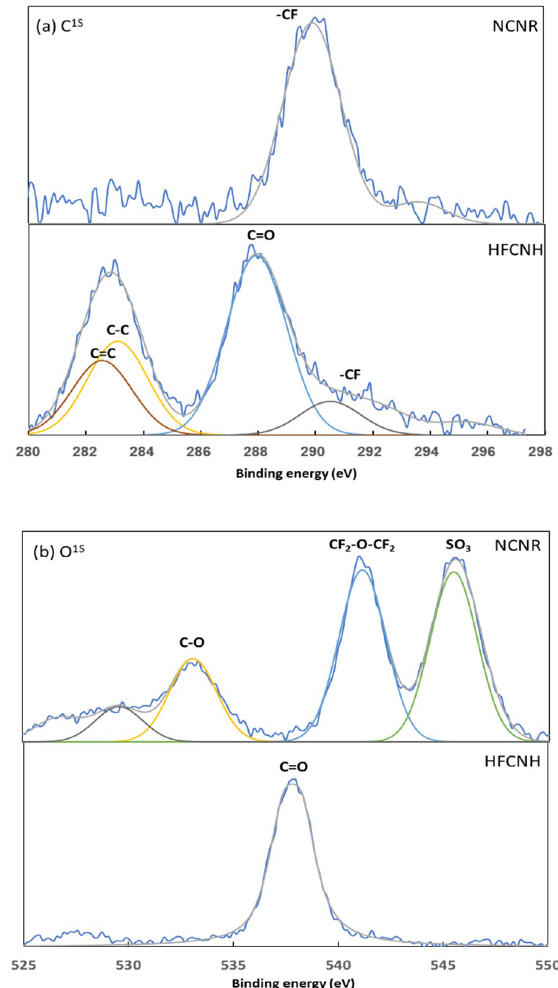
Figure 3. XPS spectra of NCNR and HFCNH with relative peak deconvolutions relative to carbon 1s ( a ) and oxygen 1s ( b ).